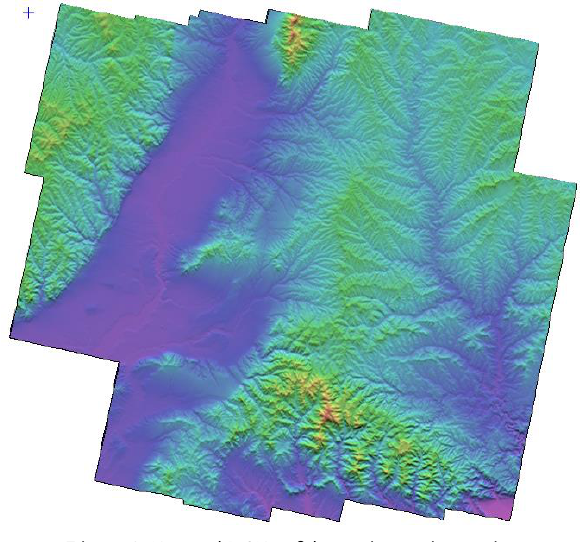
Figure 2. Merged DSM of the entire testing region Figure 2 depicts the DSM result covering the entire testing region, rendered in a coloured shade relief fashion. Table 1